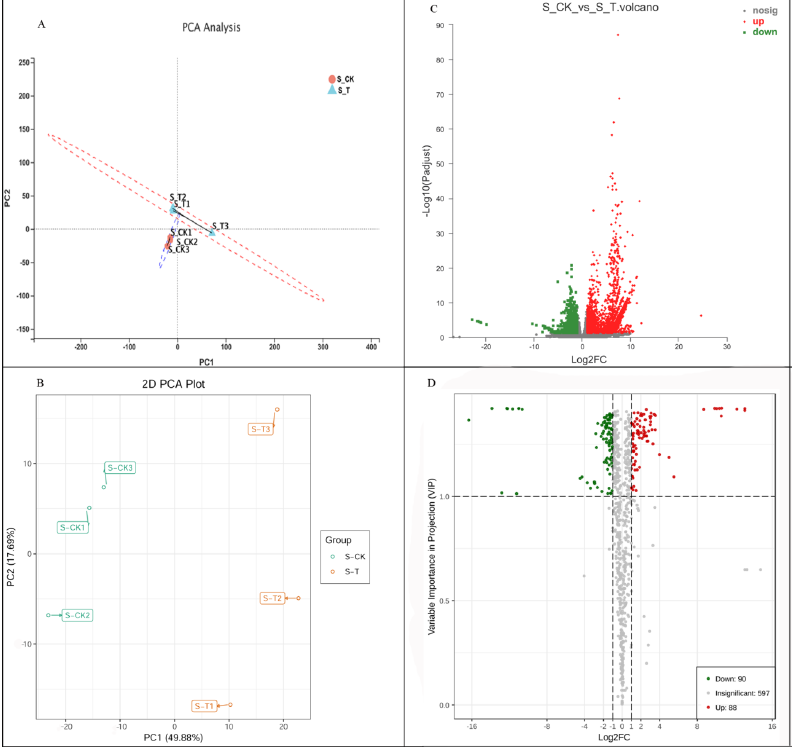
Figure 2. Differentially expressed genes and differentially accumulated metabolites between S_CK and S_T. ( A ) Principal component analysis (PCA) of the variance-stabilized estimated raw counts of differentially expressed genes. ( B ) Principal component analysis (PCA) of the variance-stabilized estimated raw counts of differentially accumulated metabolites. ( C ) Expression profiling changes of genes in thrips injection tissues. ( D ) Volcano Plot of differentially expressed genes between S_CK and S_T. Each point in the volcano map represents a metabolite, the X axis represents the logarithm of the quantitative difference of a certain metabolite in the two samples; the Y axis represents the VIP value. Samples are categorized by cultivars and thrips infestation as different marker colors and shapes. The green dots represent downregulated differentially expressed genes or differentially accumulated metabolites, the red dots represent upregulated differentially accumulated metabolites or genes, and the gray represents detected but not significantly differentially expressed genes or differentially accumulated metabolites. S_CK: Caoyuan No. 2 without thrips infection; S _T: Caoyuan No. 2 with thrips infection.